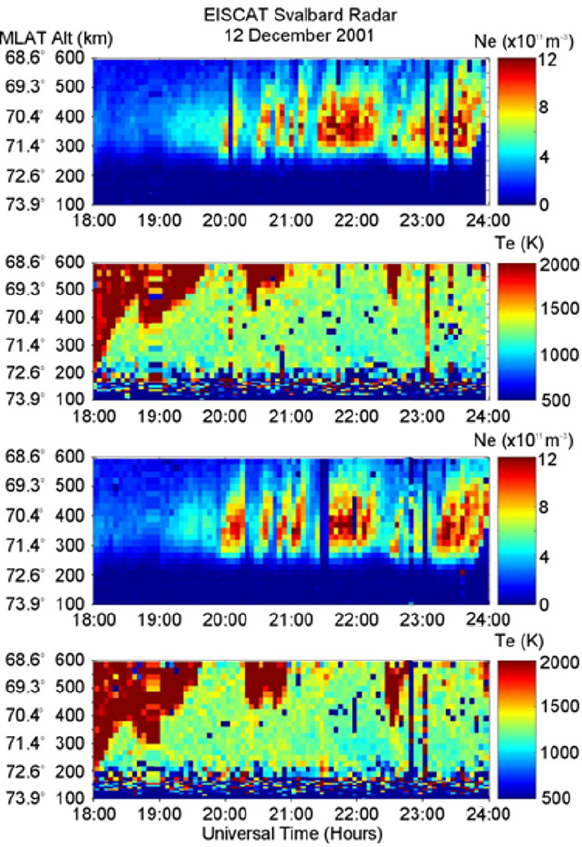
Fig. 3. Electron densities (top panel) and electron temperatures (second panel) measured by the 32m-dish of the ESR observing at an azimuth of 185.3 ◦ and an elevation of 30.0 ◦ between 18:00UT and 24:00UT on 12 December 2001. Similarly, the electron den- sities (third panel) and electron temperatures (bottom panel) mea- sured by the ESR observing at an azimuth of 170.8 ◦ and elevation of 30.0 ◦